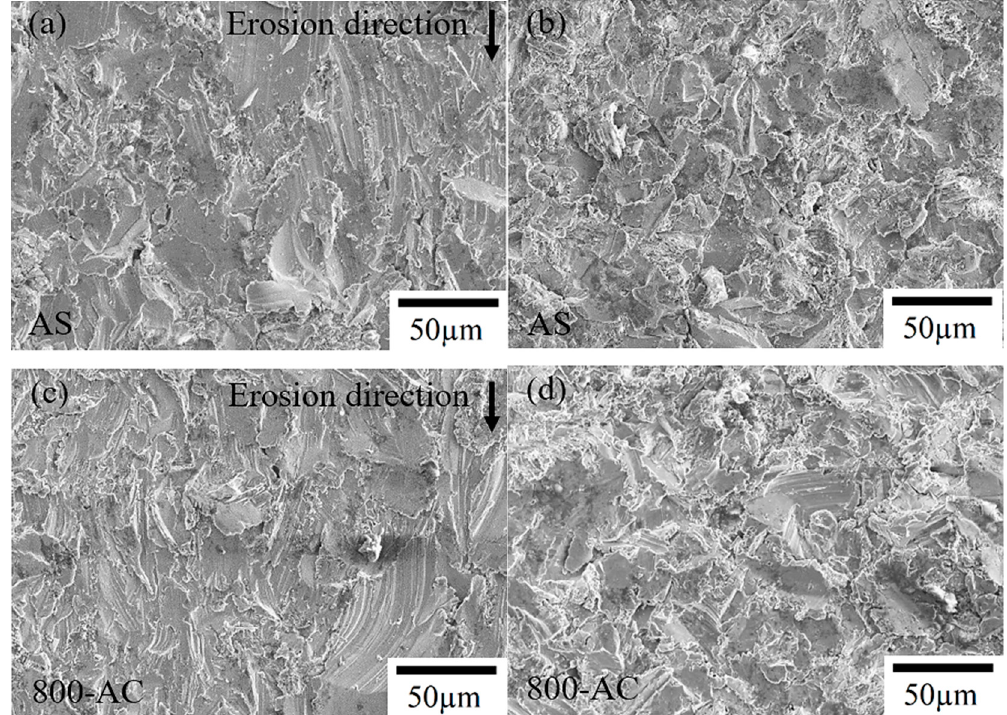
Figure 12. Surface morphologies of AS at ( a ) 30° and ( b ) 90°. Surface morphologies of 800-AC at ( c ) 30° and ( d ) 90°.